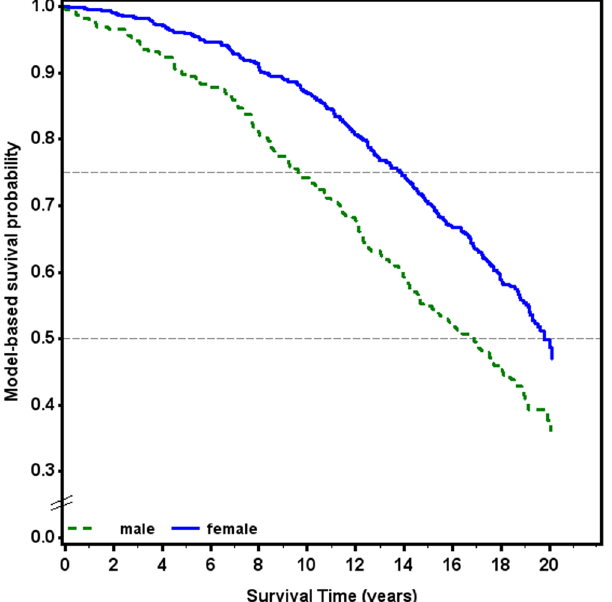
Figure 3. Adjusted survival probabilities stratified for sex. Estimated in Model 2 and adjusted for age, current smoking, self-reported history of overweight/obesity, diabetes, hypertension, cardiac insufficiency, uric acid, cholesterol, and laterality and secondary or primary cause of